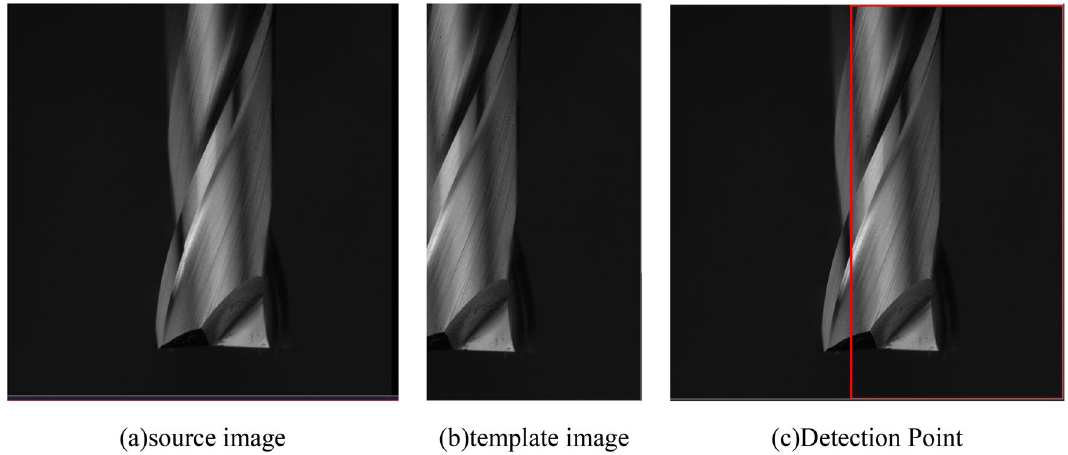
Figure 5. The schematic of the template matching